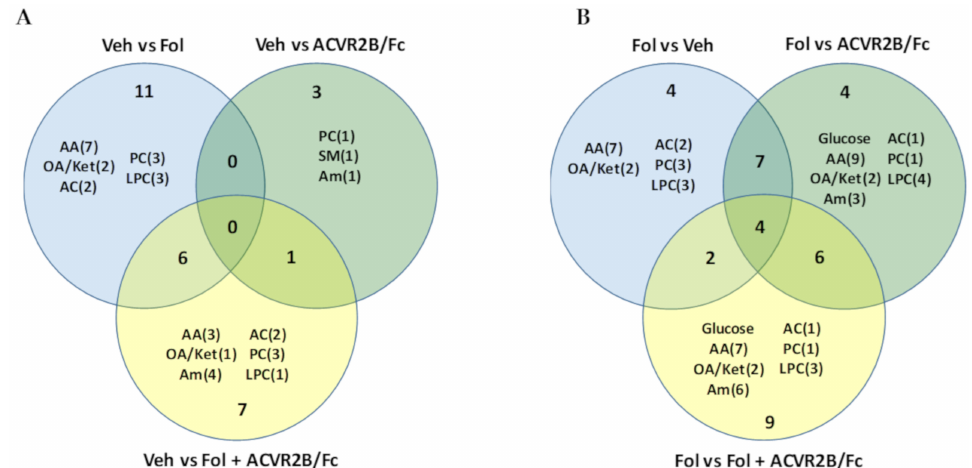
Figure 7. ( A ) Venn diagram of the di ff erences in the muscle tissue extact metabolome between the vehicle treated group and the other three groups. Annotations inside each circle indicate the number of metabolites in di ff erent chemical classes that make up the di ff erences. ( B ) Venn diagram of the di ff erences between the Folfiri treated group and the other groups. AA, amino acids; OA / Ket, organic acids and ketones; Am, amines; AC, acylcarnitines; PC, glycerophosphcholines, LPC, lysophosphocholines; SM, sphingomyelines.